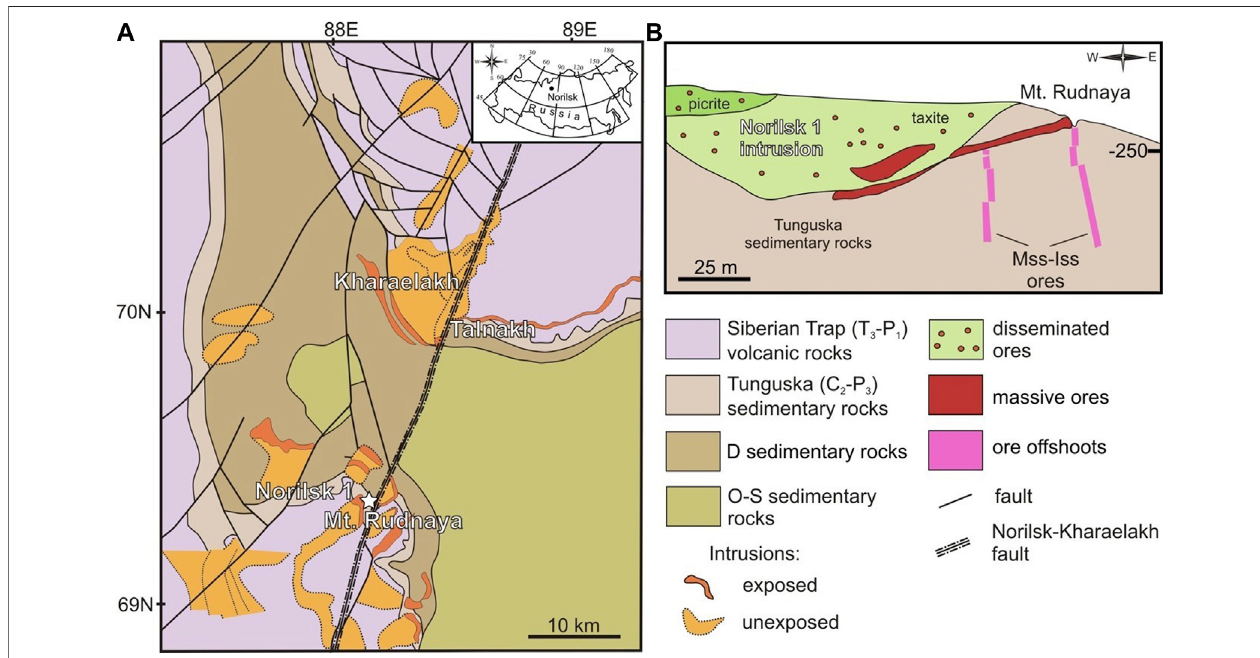
FIGURE1|(A) Simpli fi edgeologicalmapoftheNorilsk-TalnakhdistrictwithlocationsofmaindepositsandMt.Rudnaya(modi fi edafterunpublishedmapcompiled by V.A. Fedorenko); (B) schematic cross-section through the NE terminations of the Norilsk 1 intrusion and Mt. Rudnaya ores (Distler et al., 1996). O-S = Ordovician- Silurian, D = Devonian, C 2 = upper Carboniferous, P 1 = early Permian, P 3 = upper Permian, T 3 = upper Triassic.